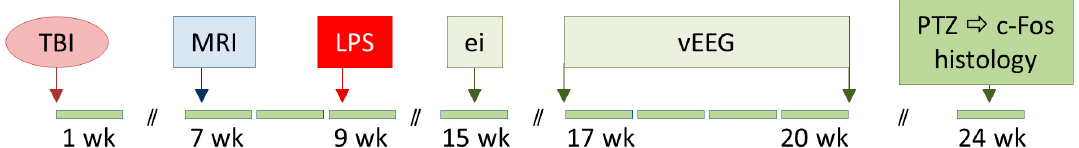
Figure 1. Study design. Traumatic brain injury (TBI) was induced by lateral fluid-percussion injury (FPI). Lesion endophenotype (focal inflammatory [TBI FI ] vs. cavity-forming [TBI CF ]) was assessed with T2-weighted magnetic resonance imaging (MRI) at 6 weeks after TBI. At 8 weeks post-TBI, rats received a single injection of lipopolysaccharide (LPS; 5 mg/kg, i.p.) or vehicle. Epidural skull electrodes (ei) were implanted at 14 weeks following TBI. Thereafter, 4-week-long video- electroencephalogram (vEEG) monitoring was performed starting at 16 weeks after TBI to detect spontaneous seizures. The pentylenetetrazole (PTZ) seizure-susceptibility test was performed under vEEG at 23 weeks post-TBI (i.e., 15 weeks after LPS injection). Finally, rats were perfused for histology at 2 h after PTZ administration (~6 months post-TBI). Sham-operated controls underwent all of the same procedures except the induction of